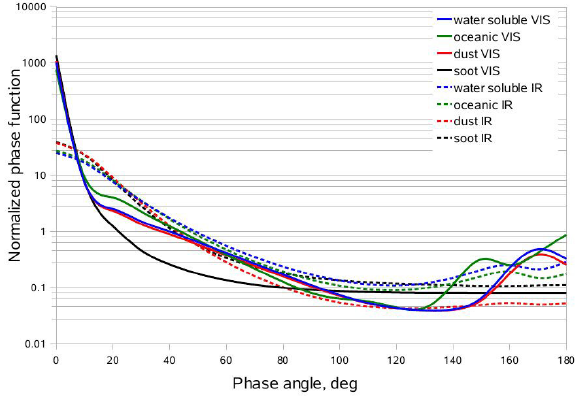
Table 2. SSA, real n and imaginary χ part of the refractive index for coarse and accumulation mode of water soluble, oceanic, dust and soot aerosol components at